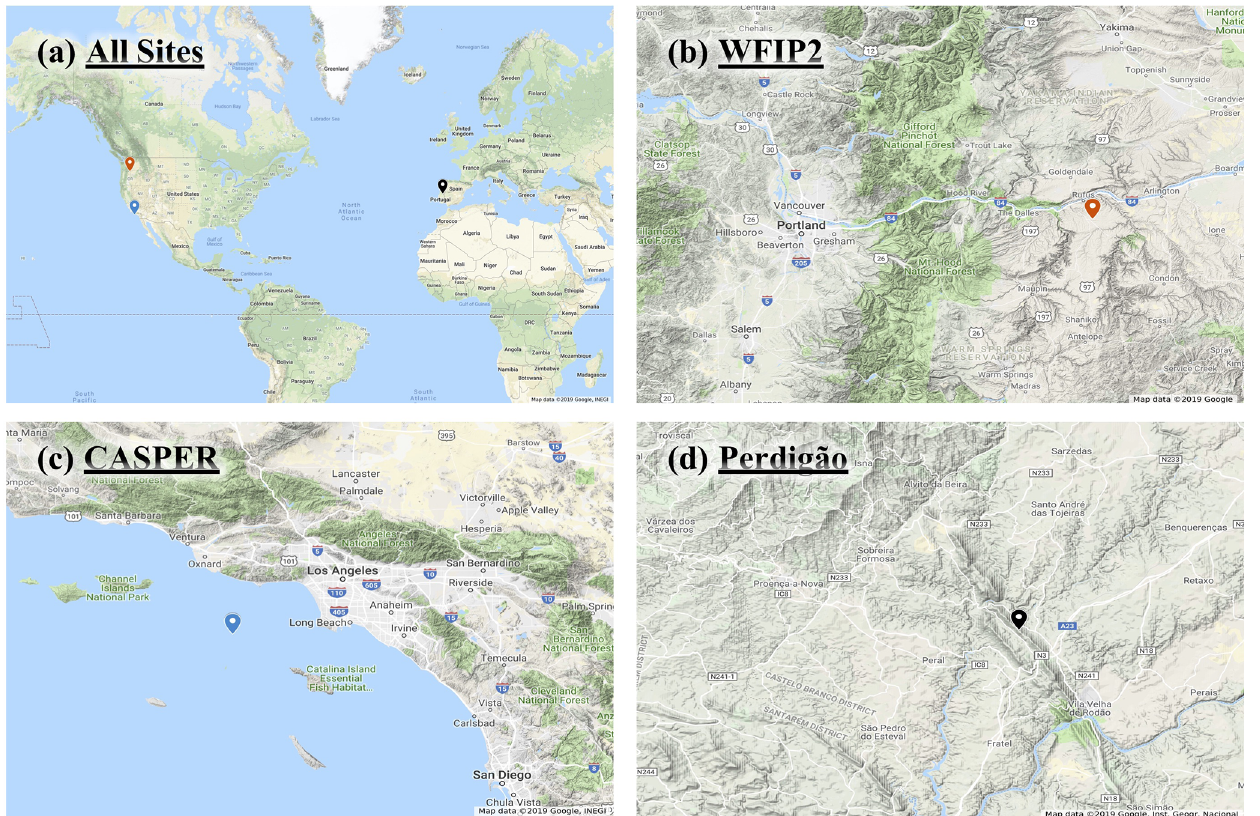
Figure 2. Panel (a) depicts all site locations. The remaining three panels depict topography at (b) WFIP2, (c) CASPER, and (d) Perdigão. Map data © 2019 Google, INEGI and Inst. Geogr.